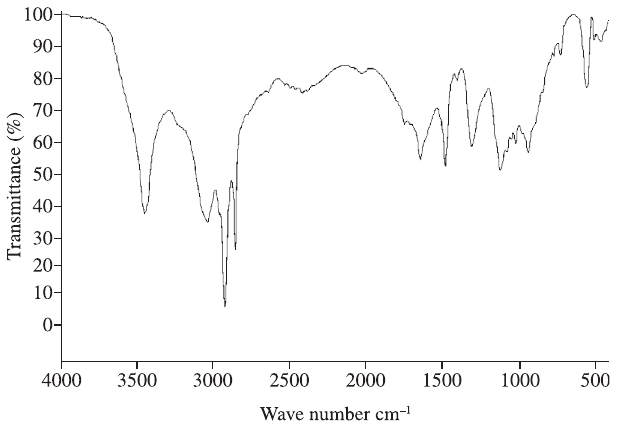
Figure 7. Ultraviolet-visible spectroscopic analysis of mesoporous Mn – organophosphate molecular sieve.